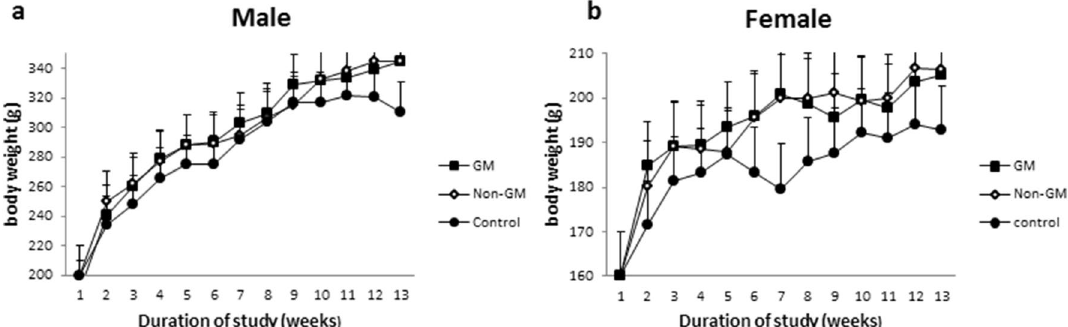
Figure 1. ( a ) Mean weekly body weight of male rats fed on different diets ( b ) Mean weekly body wight of female rats fed on different diets.